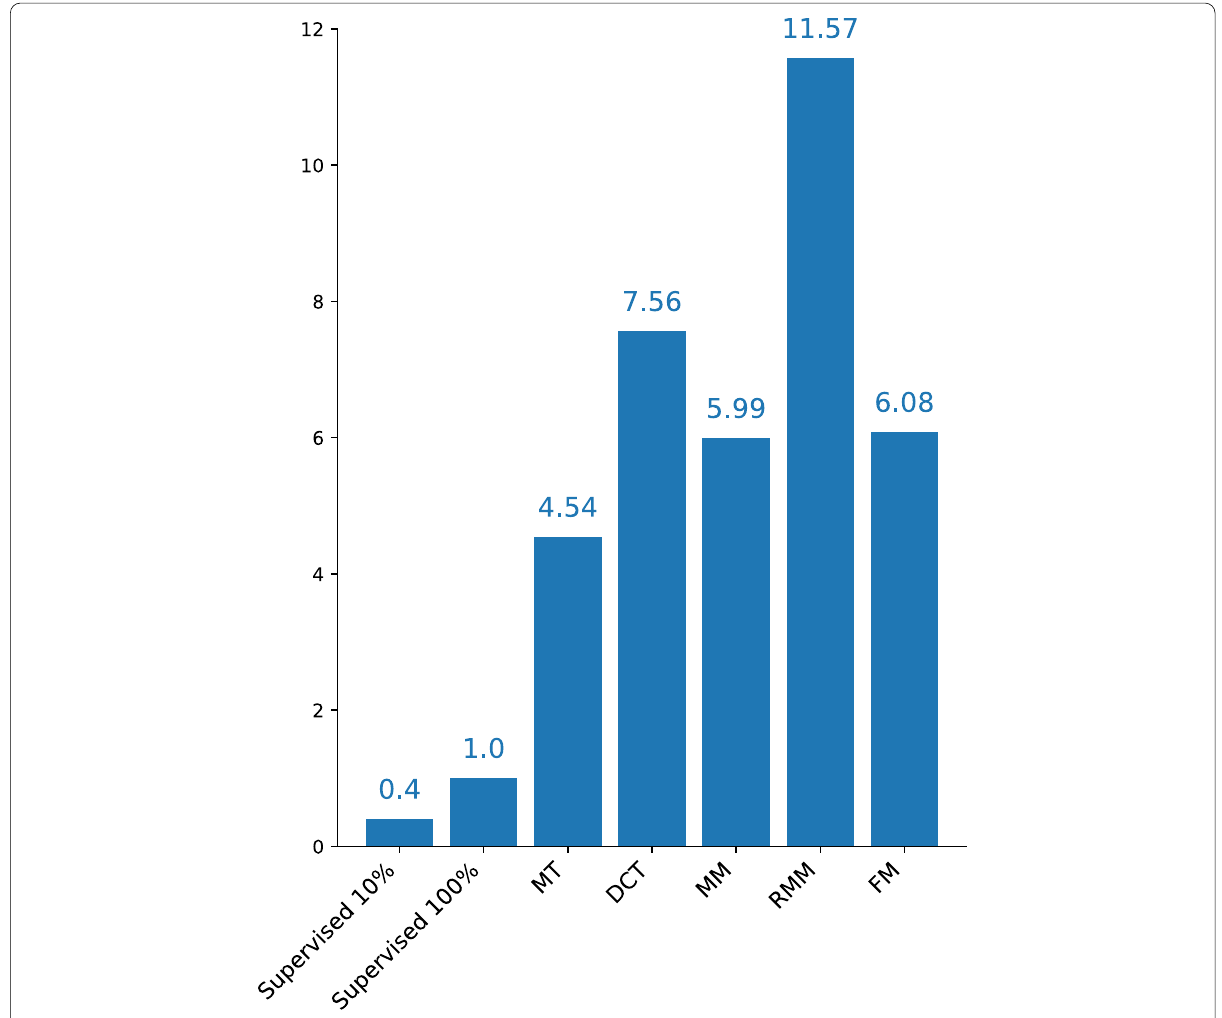
Fig. 6 Normalized mean training duration for all methods without